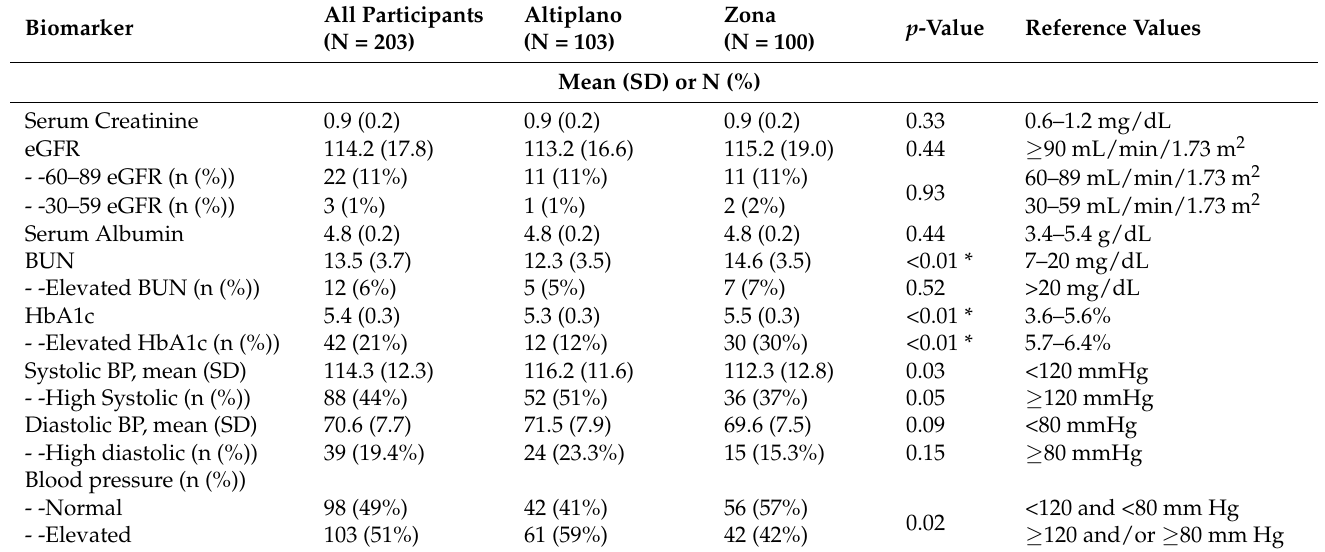
Table 2. Markers of underlying health among participants, mid-harvest, January 2019.